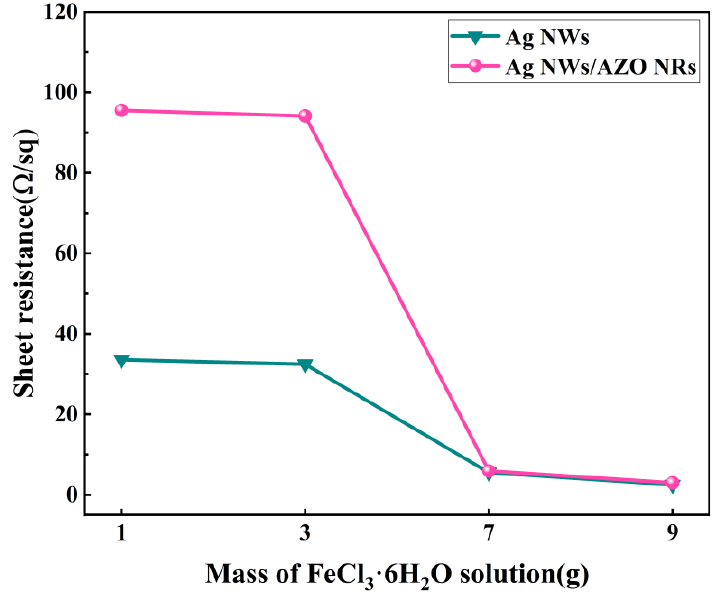
Figure 5. Sheet resistances of Ag NWs films on the AZO SL and Ag NWs/AZO NRs composite films.